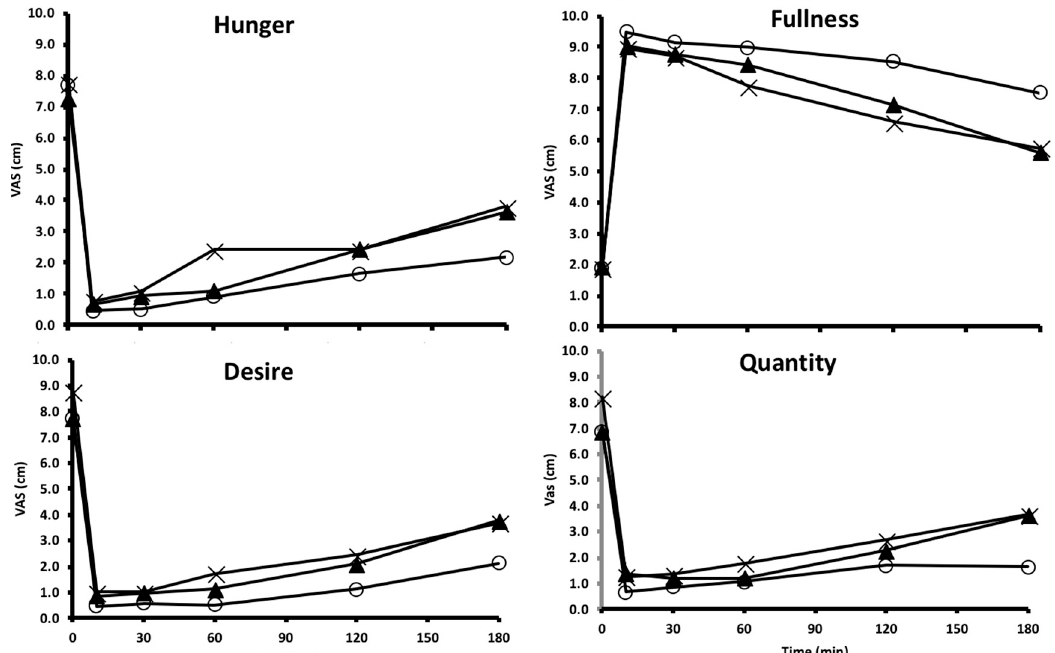
Figure 2. Plots of visual analogue scales (VAS) in response to four questions over time starting at baseline (t = 0) and following the consumption of pasta (×), potato ( ○ ) and rice ( ▲ ) meals. Data were analyzed by comparing the area-under-the-curve (AUC) among the meals for each of the questions. Interpretation of the data: How hungry do you feel? (Small AUC—Not at all hungry; Large AUC— Extremely hungry). How full do you feel? (Small AUC—Not at all full; Large AUC—Totally full).